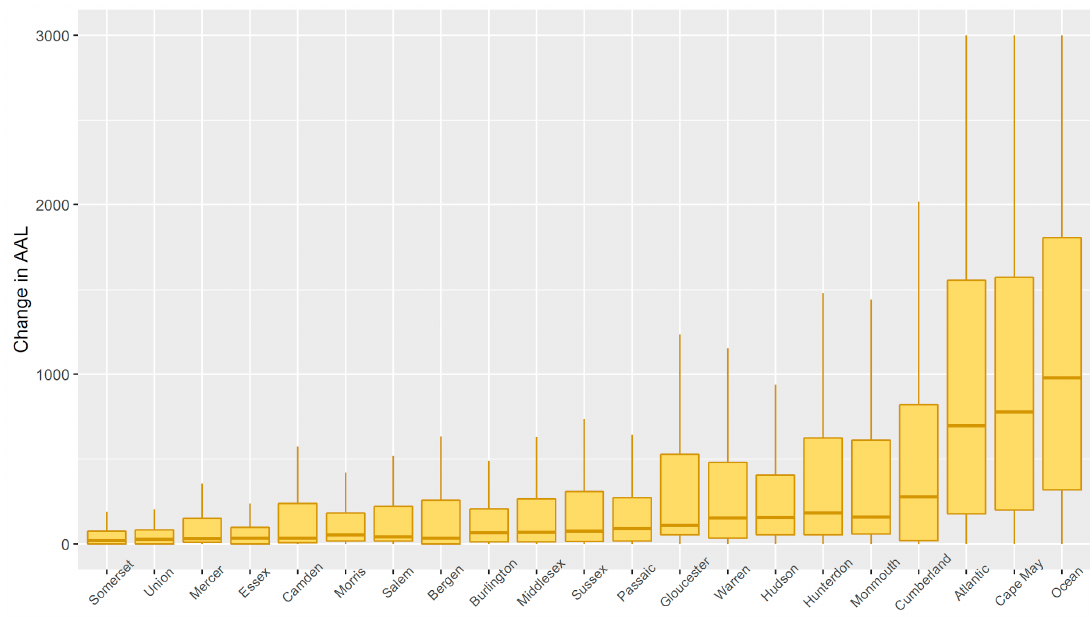
Figure 8. The increase in total expected annual loss from 2020 to 2050, access different counties.